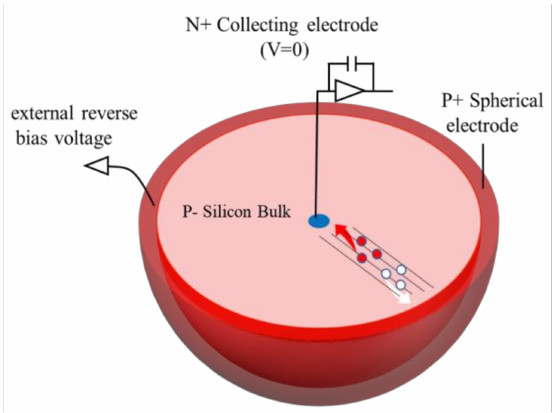
Figure 1. Schematic of the hypothetical hemispherical electrode